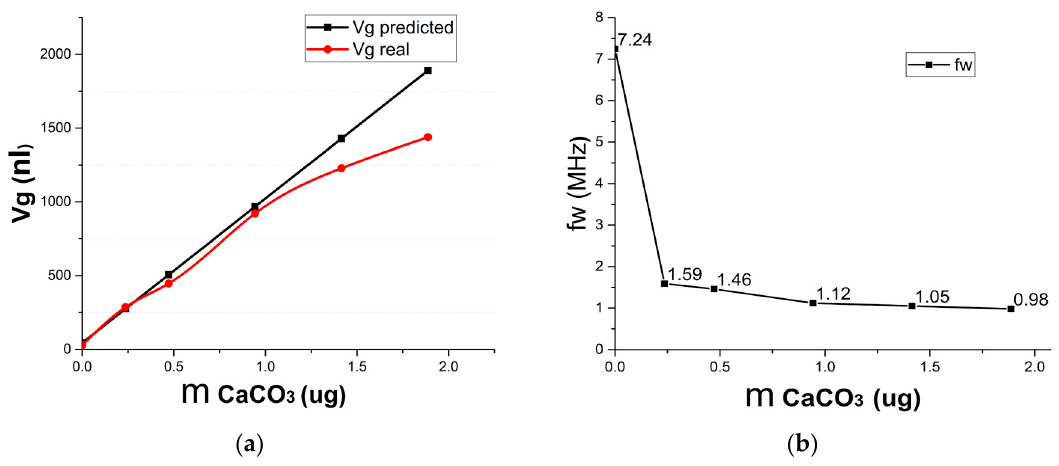
Figure 7. The effect of CaCO 3 on the volume and four-node wineglass resonant frequencies of HSR samples: ( a ) Calculated volume versus real volume of HSR samples; ( b ) The four-node wineglass resonant frequencies of the HSR samples.